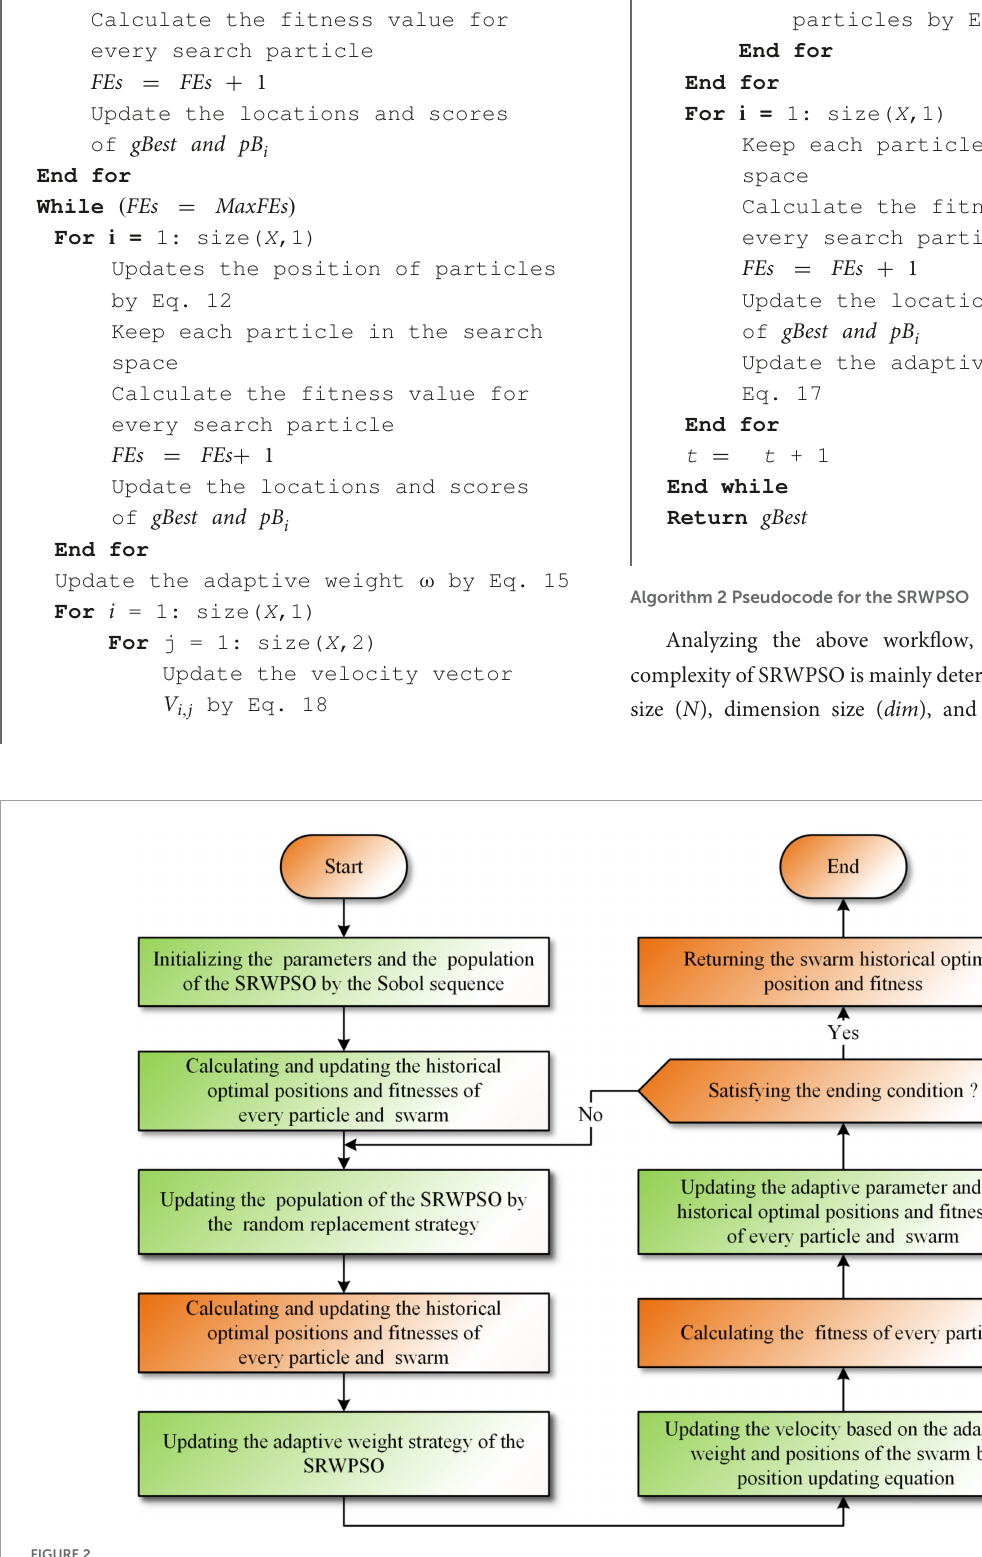
FIGURE2 The workflow diagram of the